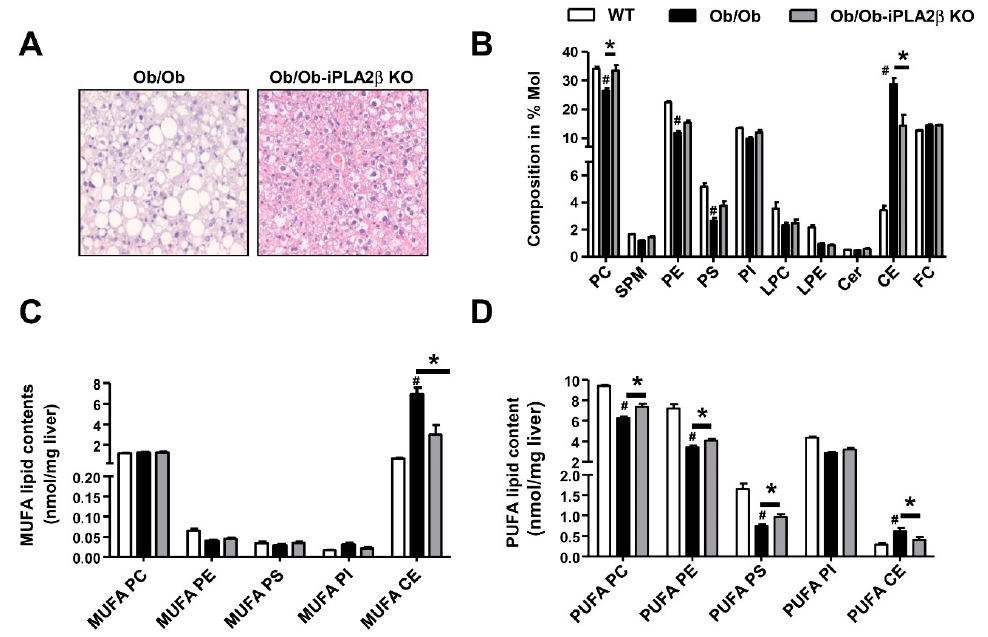
Figure 2. iPLA 2 β inactivation in Ob/Ob mice rescues the defect of hepatic PL remodeling. Male WT, Ob/Ob, and double knockout Ob/Ob-iPLA 2 β KO at six months old were used. ( A ) Representative